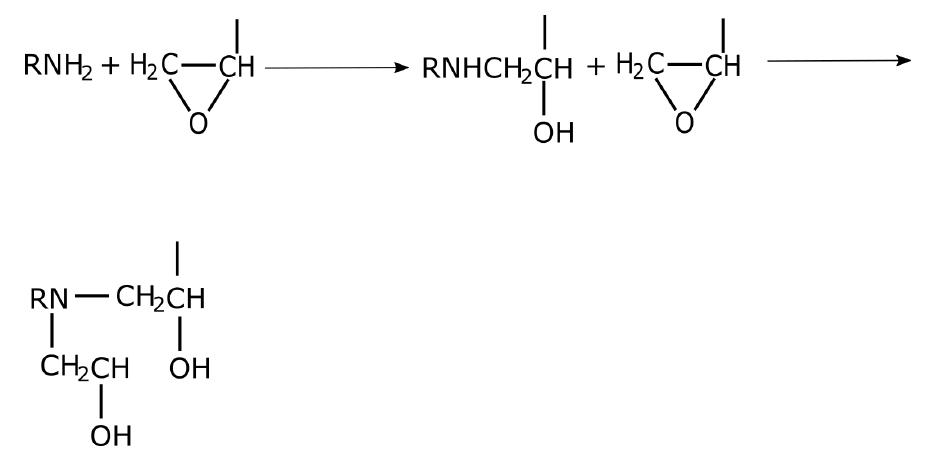
Figure 4. Mechanism of cure of primary or secondary amines.